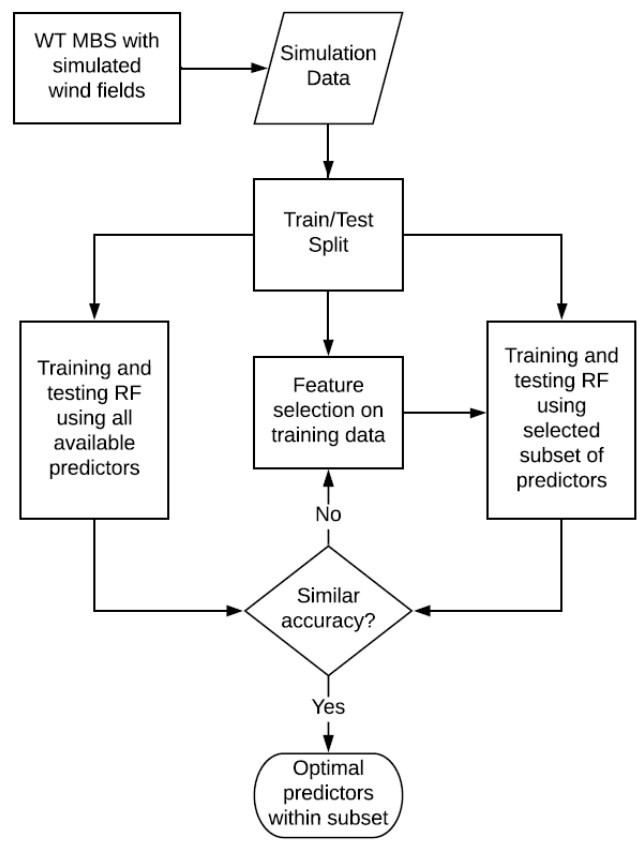
Figure 2. Overview of methodology.